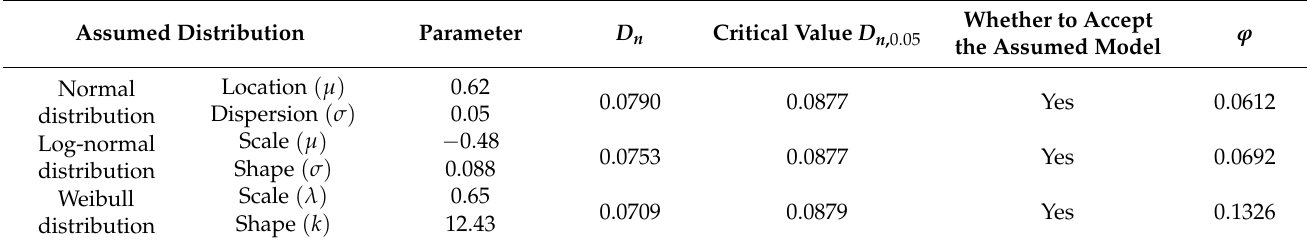
Table 4. K–S test result and probabilistic distribution of the lamina density.